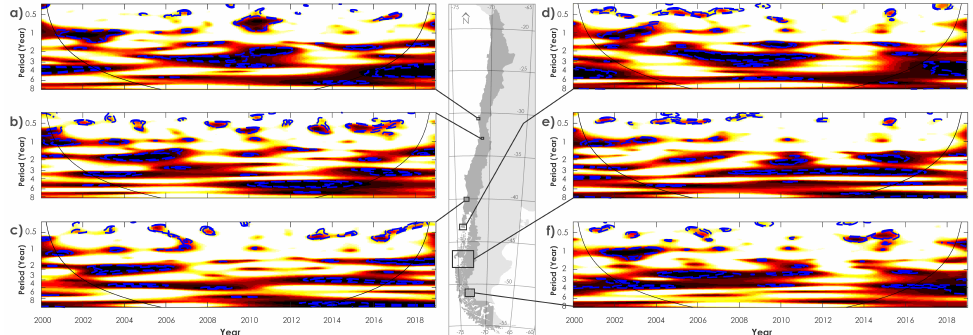
Figure 4. Wavelet coherence between the EVI and MEI temporal signal in national parks. ( a ) Fray Jorge, ( b ) La Campana, ( c ) Alerce Costero, ( d ) Tantauco, ( e ) San Rafael and ( f ) Torres del Paine. The colors are coded from yellow (low coherence) to dark red (high coherence). The dotted-dashed blue lines show the 95% and the 90% significance levels computed based on bootstrapped series. The cone of influence (black line) indicates the region not influenced by edge effects (see